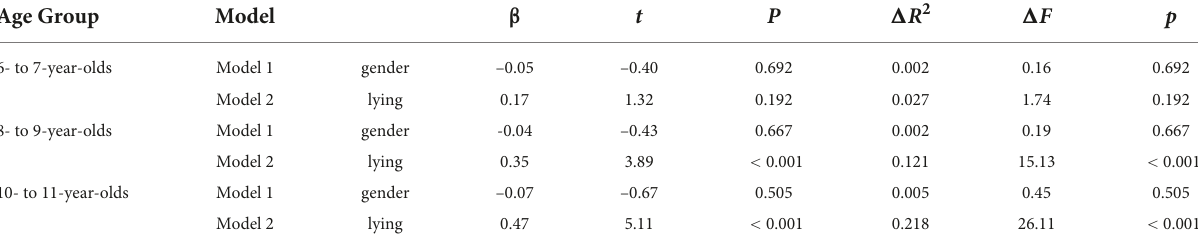
TABLE 2 Hierarchical regression analyses for predictors of children’s behavior problems in each age group.